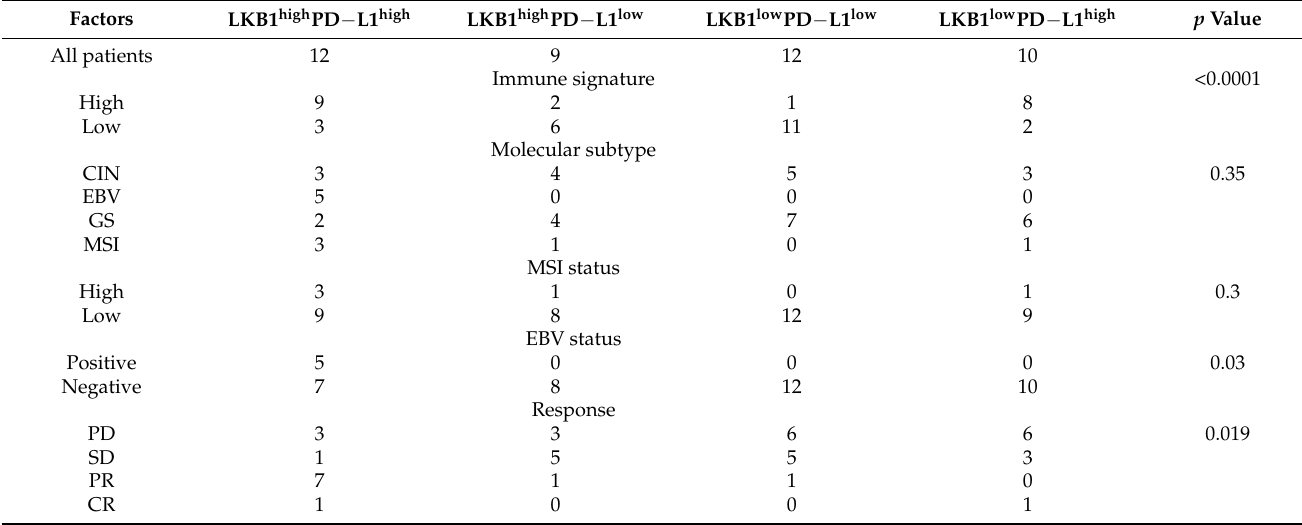
Table 4. Association between LKB1/PD − L1 expression and molecular